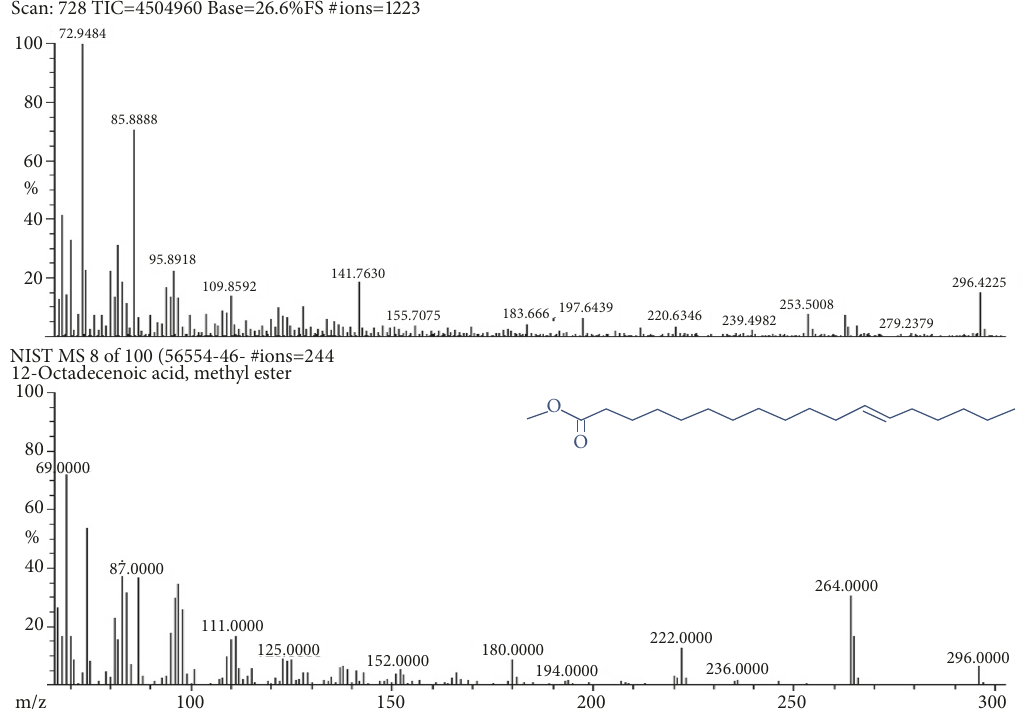
Figure 4: Mass spectra of 12-Octadecenoic acid, methyl ester compound in the Erythrina variegata methanolic leaf extract.